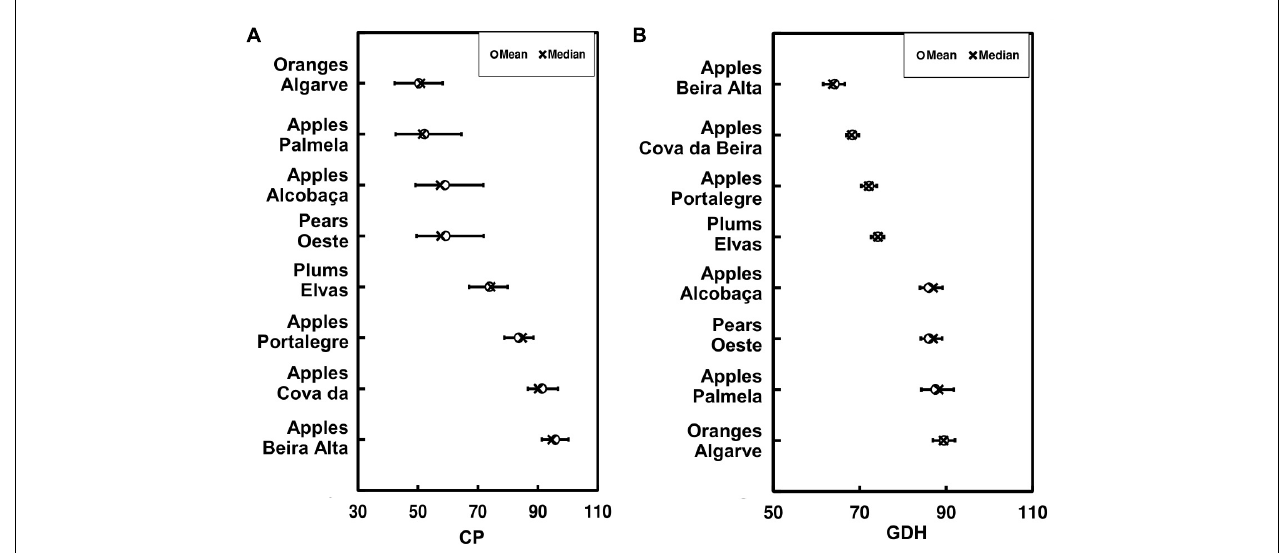
FIGURE 3 | Boxplots representing the chilling portions (CP) (A) and growing degree hours (GDH) (B) over the selected eight fresh fruit regions. The regional mean (circle) and median (cross) are depicted, as well as the minima and maxima (outer dashes). The regions are ranked from the lowest to the highest mean values of SWC and SHF, respectively. GDH and SHF values are shown in × 10 3